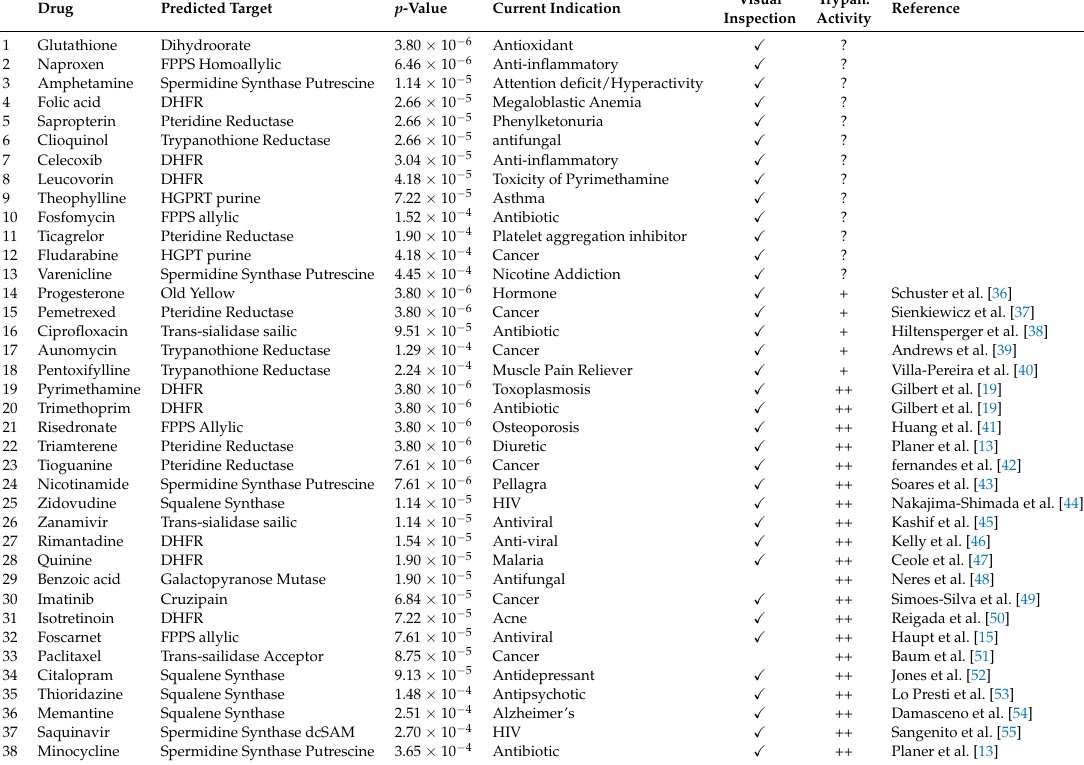
Table 2. Computational screening hits predicted to bind Chagas targets. Top 38 hits from the screening sorted by novelty with regard to trypanocidal activity, where ? indicates unknown activity, + indicates indirect evidence of activity, and ++ indicates direct evidence of activity. Within each of the previous classifications, the hits are sorted by screening p -value and the original indication is shown. The (cid:88) represents positive visual inspection, meaning high interaction pattern similarity between query and